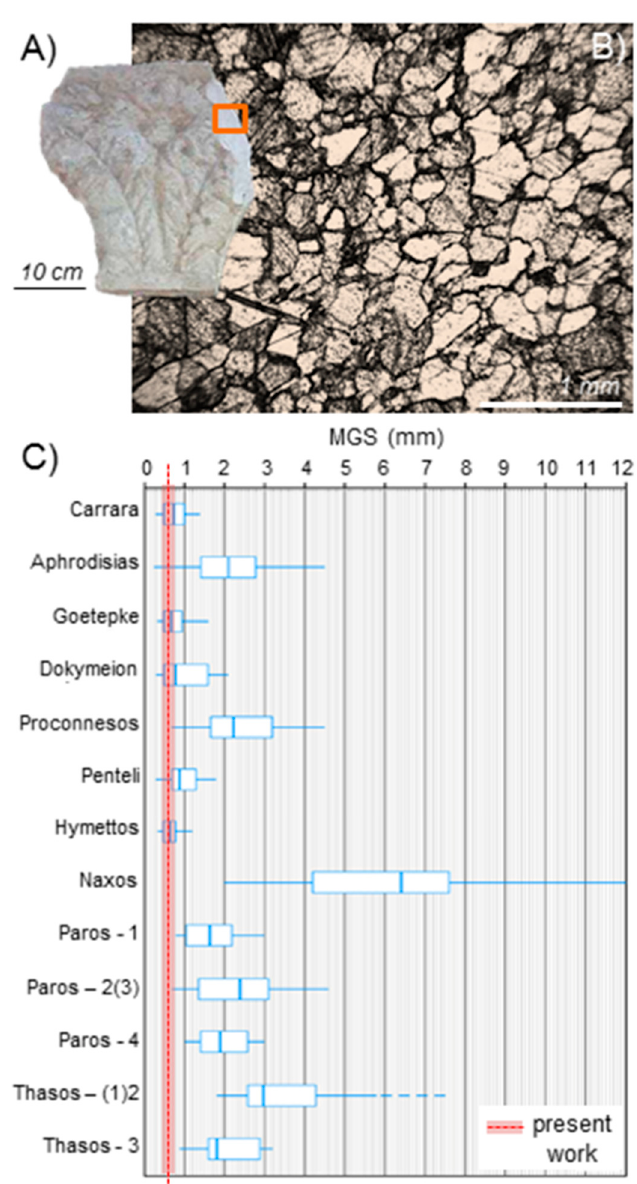
Figure 7. Marble characterisation. ( A ) Macrophotography of the fragment GPT’03 300-3, courtesy of the Superintendence of Archaeology, Fine Arts and Landscape for the metropolitan city of Genoa and the provinces of Imperia, La Spezia and Savona (partial or total reproduction is forbidden without prior (written) permission). ( B ) Microphotography, crossed polars. The marble is homeoblastic, organised in a granoblastic texture, with low-grade anisotropy and linear to lobate grain boundaries. ( C ) Comparison between maximum grain size (MGS) values of the white marbles most di ff used in ancient times (graph modified from Antonelli and Lazzarini [11]). The red dotted line presents the mean MGS value of the sample from the present study, and the red area corresponds to the Gaussian curve of the measured MGS